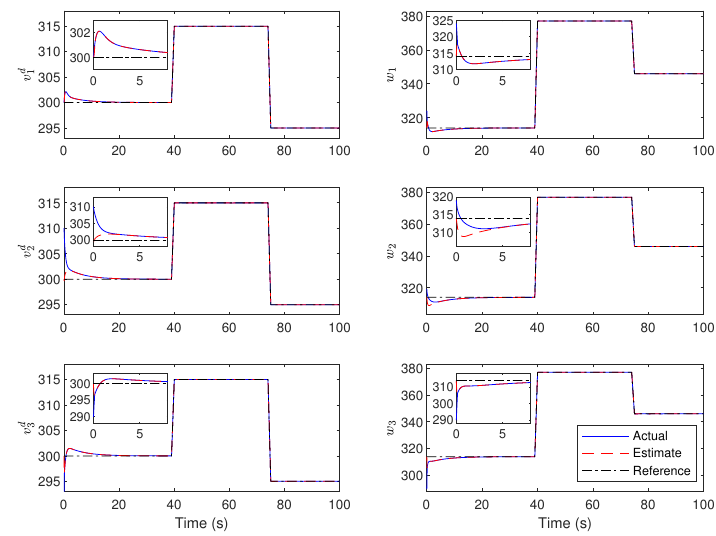
Figure 7. The states of system (53) (solid), their estimates from the central SMO (dashed), and the reference value (dash-dotted) for the case where u cc is implemented as designed in (58).